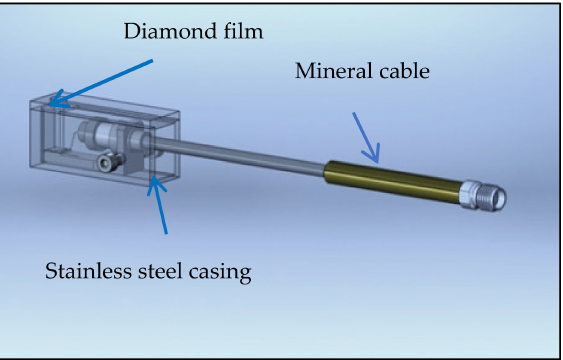
Figure 21. 3D CAD drawing of the prototype diamond detector for operation at high temperature.